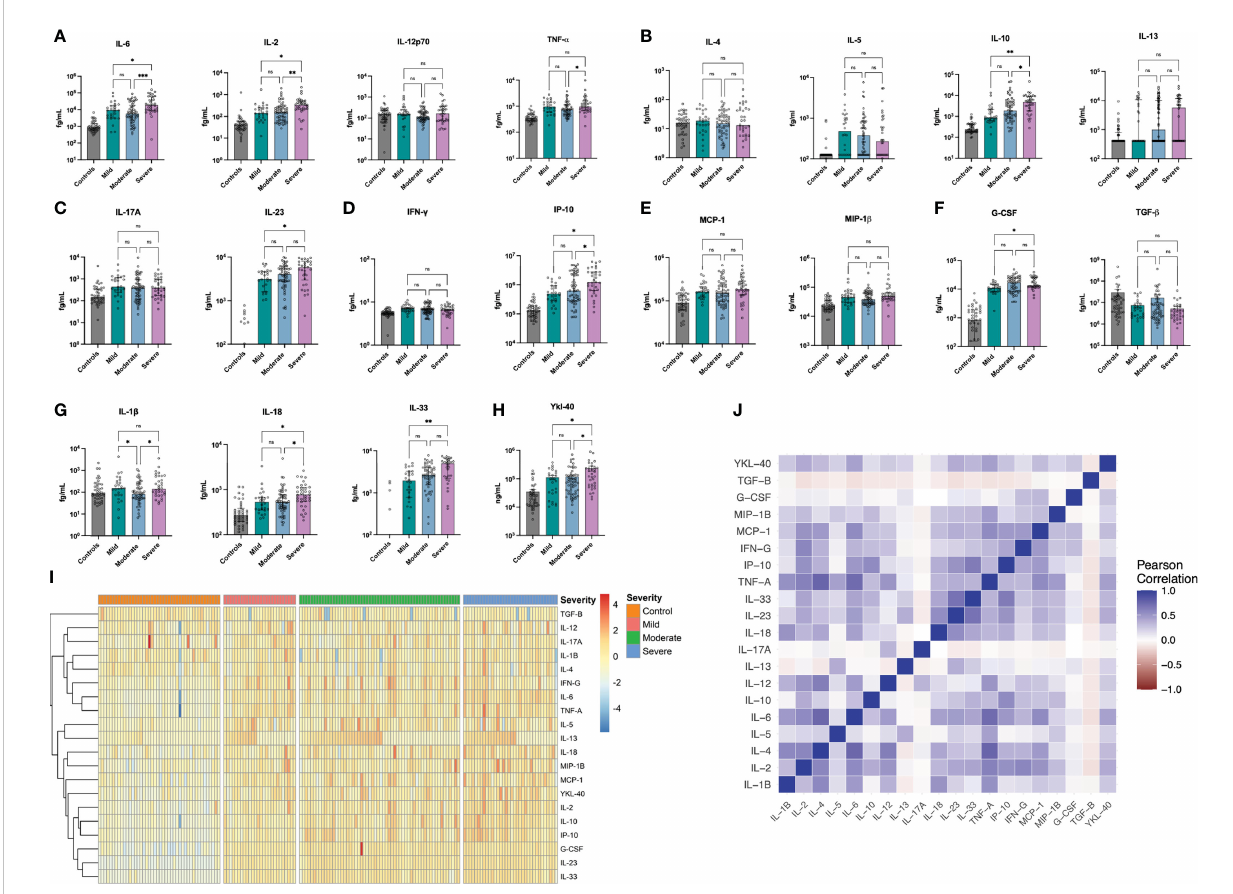
FIGURE 1 Cytokine Concentrations in Acute COVID-19. IL-1 b , IL-4, IL-5 and IL12p70 were not signi fi cantly elevated in acute COVID-19 patients whilst all other cytokines were signi fi cantly elevated (TGF-B was signi fi cantly lower in acute COVID-19). Eleven Markers, namely IL-1 b , IL-2, IL-6, IL-10, IL-18, IL-23, IL-33, TNF- a , IP-10, G-CSF and YKL-40 all differed signi fi cantly by COVID-19 Severity. Data are presented for controls (n = 44) and those with mild (n = 26), moderate (n = 58) and severe (n = 44) COVID-19 for NF-kB-dependent IL-6 & Th1 cytokines (A) , Th2 cytokines (B) , Th17 cytokines (C) , interferon-related proteins (D) , chemokines (E) , growth factors (F) , IL-1 family cytokines (G) and Ykl-40 (H) . Results are presented for A-H in femtograms/mL (fg/mL) on a logarithmic scale. Results are also presented as a heatmap of log-transformed, z-scored concentrations based on disease severity for the entire cohort (I) and as a correlation matrix (J) demonstrating the relationships between differing markers. *p<0.05, **p<0.01, ***p<0.001, ns, non-signi fi cant. Strongest correlations were seen (R>0.7) between 6 pairs: IL-1 b & IL-4, IL-1 b & TNF- a , IL-1 b & IL-6, between IL-6 & TNF- a ; between TNF- a and IL-10 and between IP-10 & IL-33 which all persisted following Bonferonni